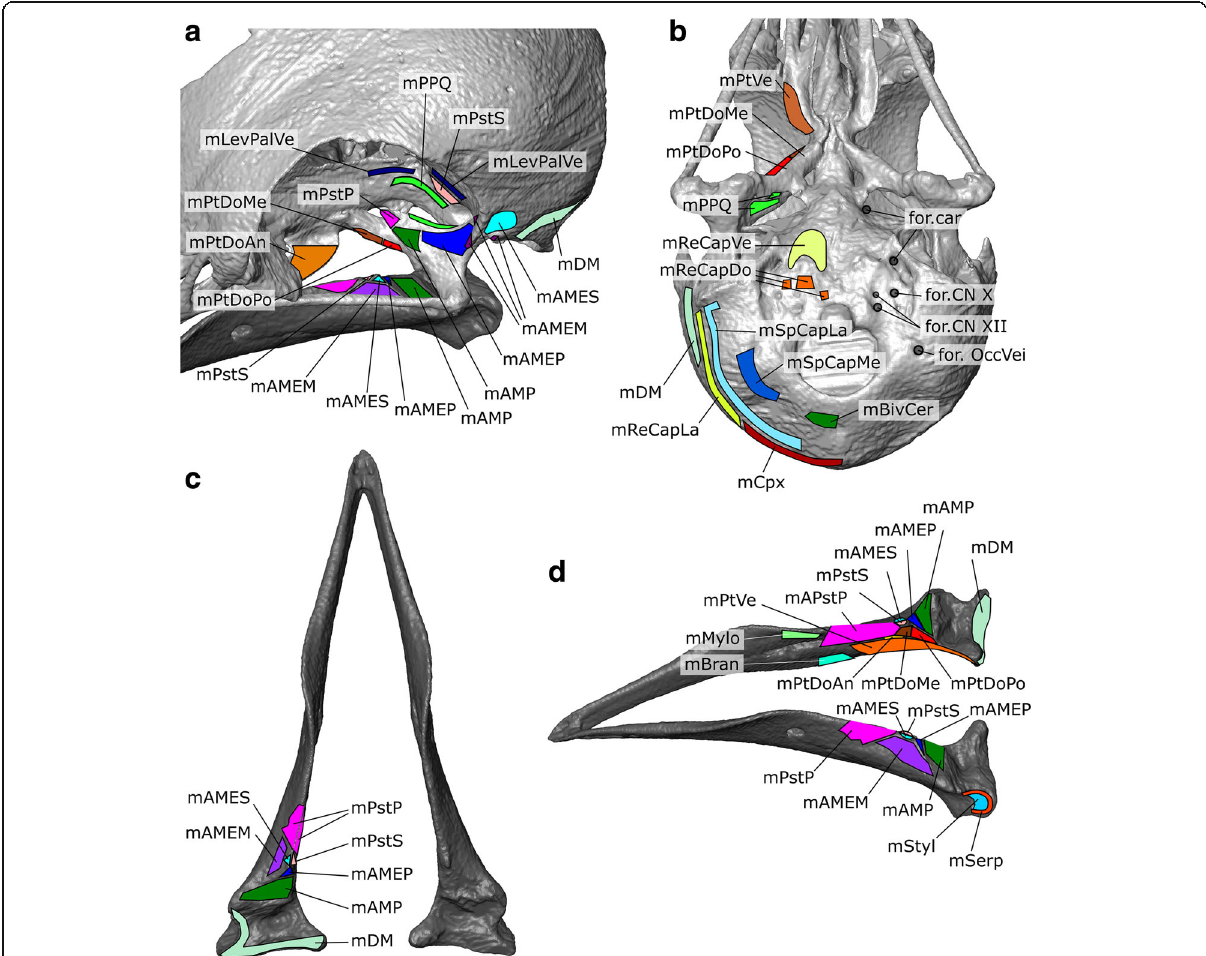
Fig. 8 The origins and insertions of the cranial muscles of Columba livia . a anterodorsal view of the left adductor chamber and orbit b ventral view of the cranium c dorsal view of the lower jaw d dorsolateral view of the lower